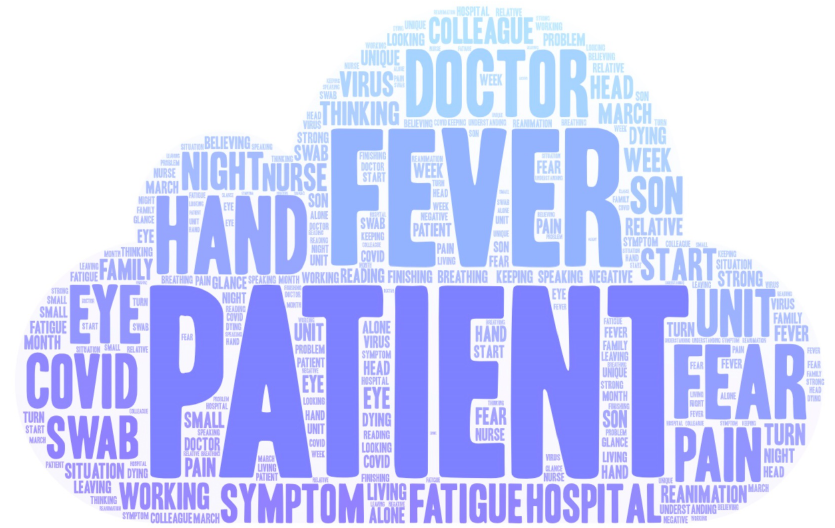
Figure 3. Word cloud showing the most frequent tokens in the document after preprocessing. Tokens with the largest font size are the most frequent.